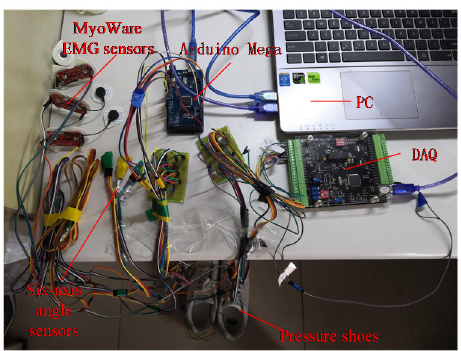
Figure 3. Designed data acquisition system.